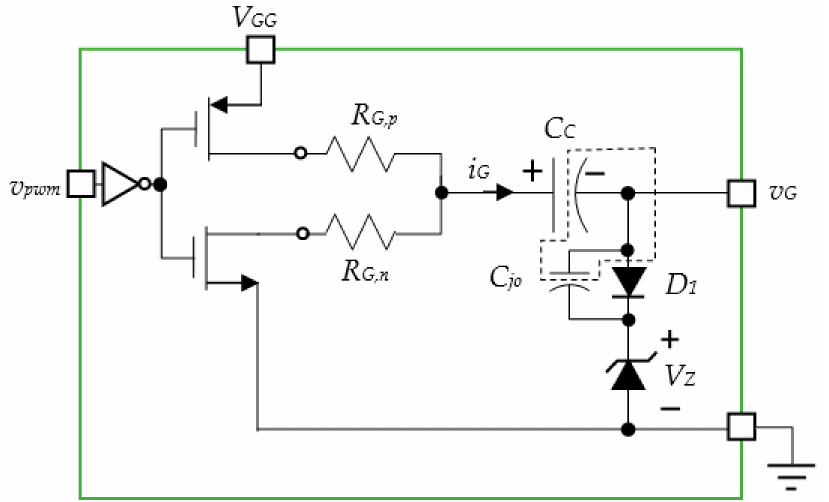
Figure 12. The biased charge-pump gate